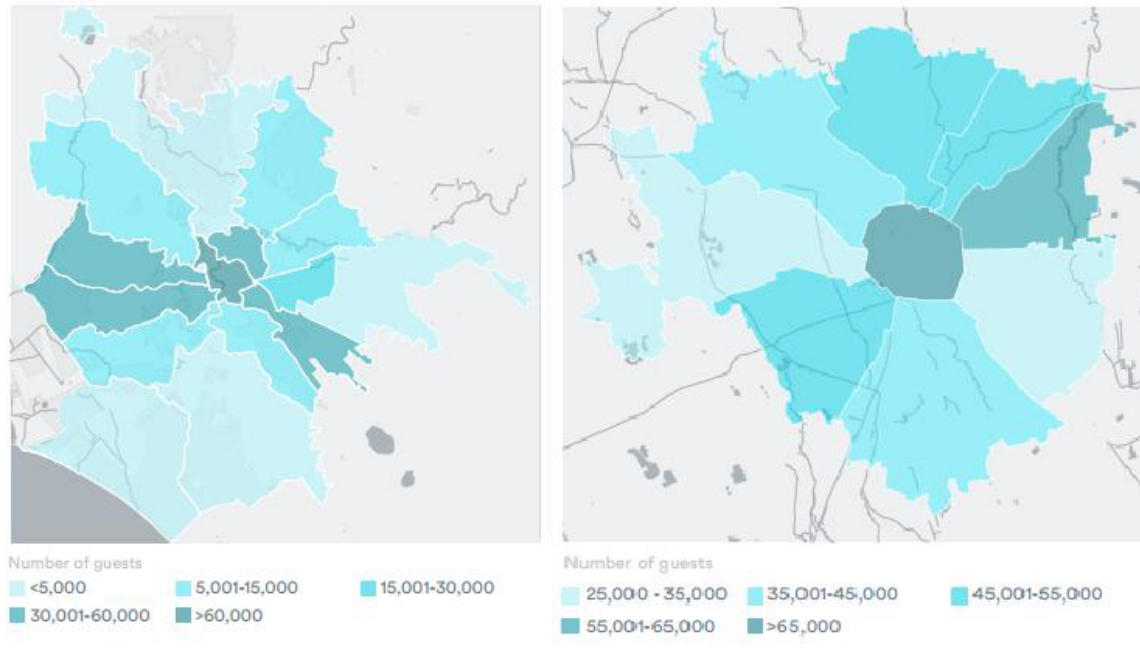
Figure 3: Airbnb in Rome and Milan, 2016